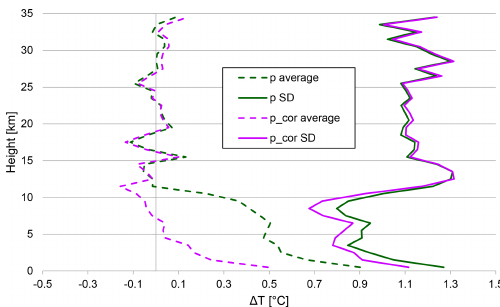
Figure 23. The temperature ( T ) bias and standard deviation (SD) between ascent and descent matched using either reported pressure (green) or corrected pressure (purple). Accumulated Praha-Libus data were used, and the friction correction was applied to all tem- peratures.